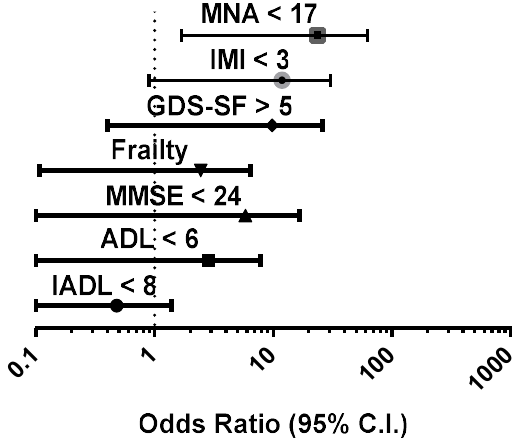
Figure 2. Odds ratios of factors associated with in-hospital mortality in a multivariate logistic regression model applied in the entire cohort studied. MNA, mini nutritional assessment; IMI, Italian Mediterranean index; GDS-SF, geriatric depression scale-short form; ADL, activities of daily living; IADL, instrumental activities of daily living; MMSE, mini-mental state examination.